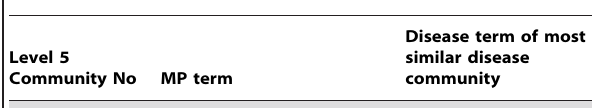
Figure 5. Mapping of MP and human disease communities to show the signifiance level of their gene membership overlap. Cells on the heatmap represent the significance of the overlap of the communities in the GPN and the disease-gene network. The intensities correspond to 2 log(p) where p is the probability of the observed overlap under the null hypothesis of random assignment of genes to communities. Dark areas have the highest values of 2 log(p) while white areas represent a low value. Numbers along the x-axis are the reference numbers of the Newman gene communities identified in the disease-gene network and numbers on the y-axis are the reference numbers of the Newman communities identified in the GPN. A) MP level 5 communities; B) MP level 8 communities.